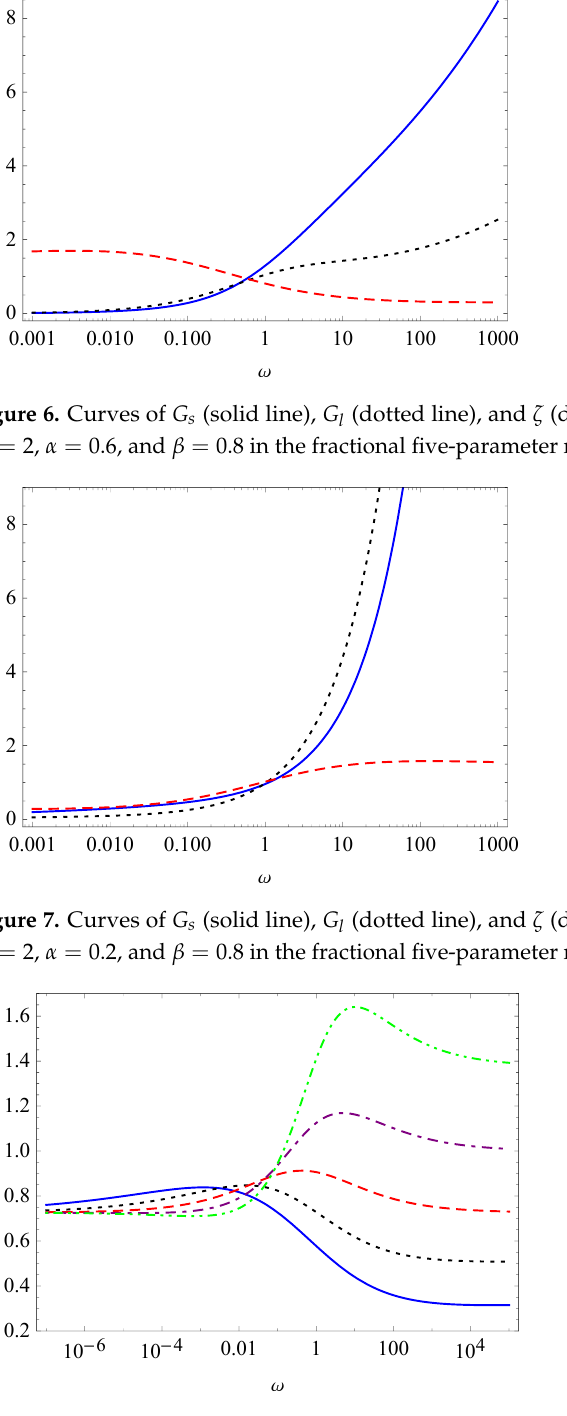
Figure 8. Curves of ζ ∼ ω for a = 1, b 1 = 1, b 2 = 2, and α = 0.4 and for β = 0.6 (solid line), 0.7 (dotted line), 0.8 (dashed line), 0.9 (dotted–dashed line), and 1 (dotted–dotted–dashed line) in the fractional five-parameter model